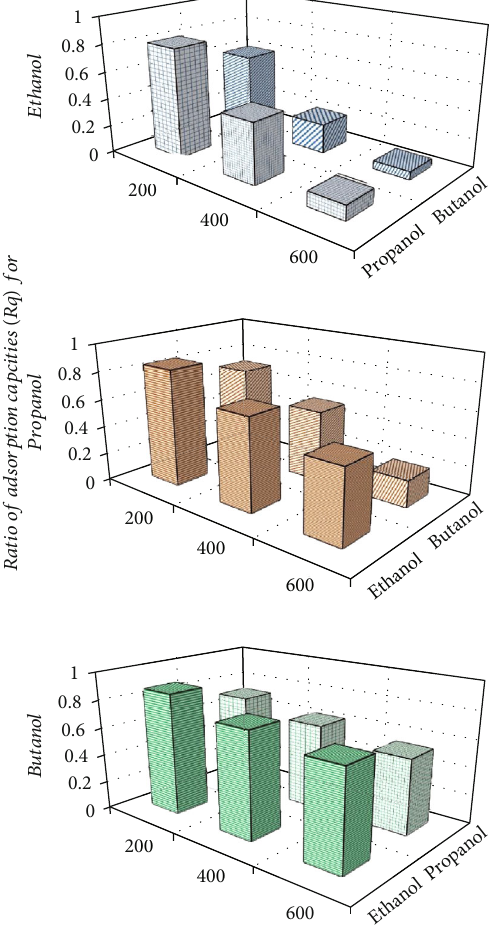
Figure 7: Comparison of competitive adsorption of ethanol, propanol, and butanol on bone char in aqueous binary alcohol solutions at pH6 and 20 °